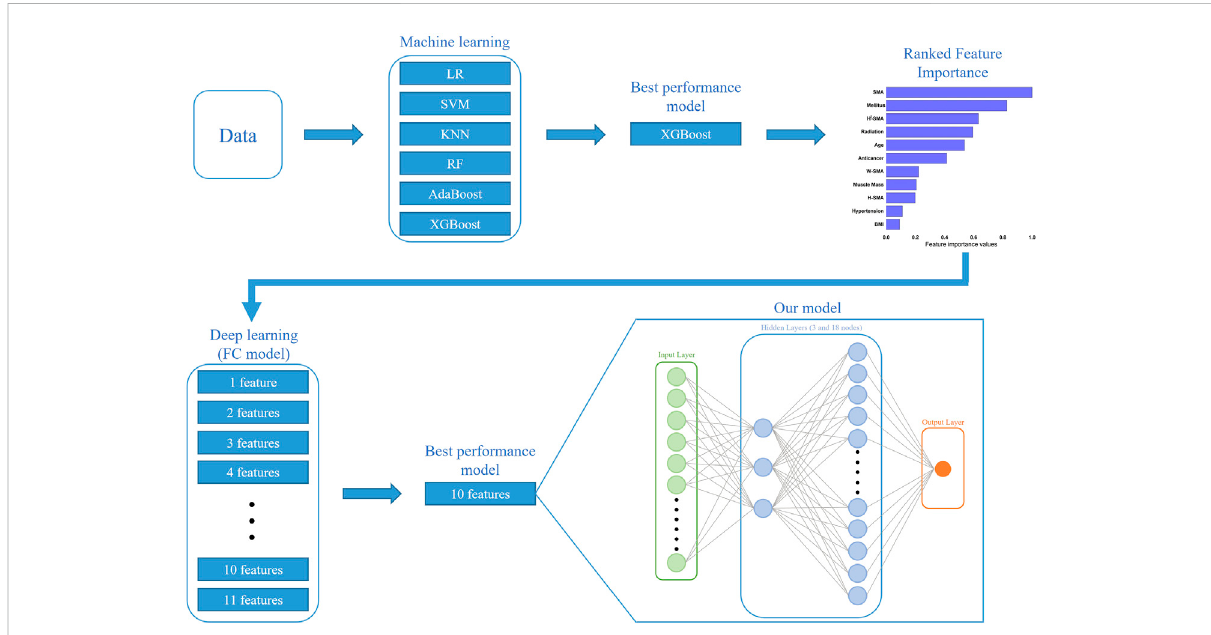
FIGURE 1 Overall strategy and architecture to build our proposed 4-layer DNN model: given the cross-validation accuracy analysis from the best classi fi er, XGBoost, we modeled with a 4-layer DNN using the top 10 features providing the best cross-validation accuracy. Results of feature importance analysis from XGBoost: SMA is with the highest